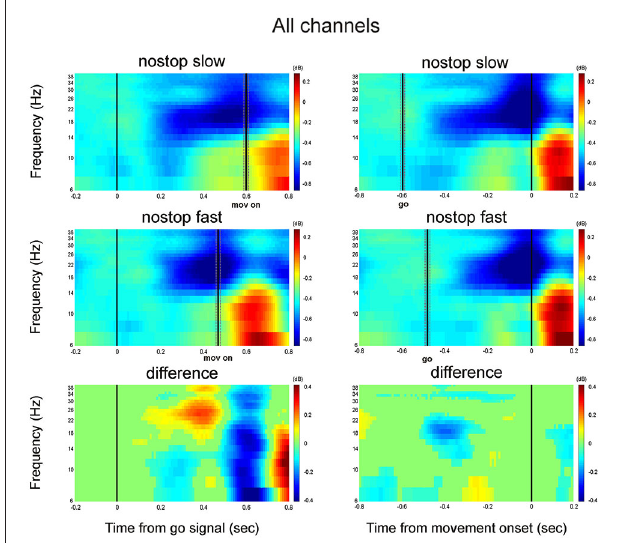
FIGURE 3 | Grand average time-frequency plot across all channels; Left column, alignment to the Go signal (go); right column: alignment to the movement onset (mov on) . Top row: grand average of slowest responses. Middle row: grand average of fastest responses. Bottom row: difference between slowest and fastest responses. Other conventions as in Figure 2